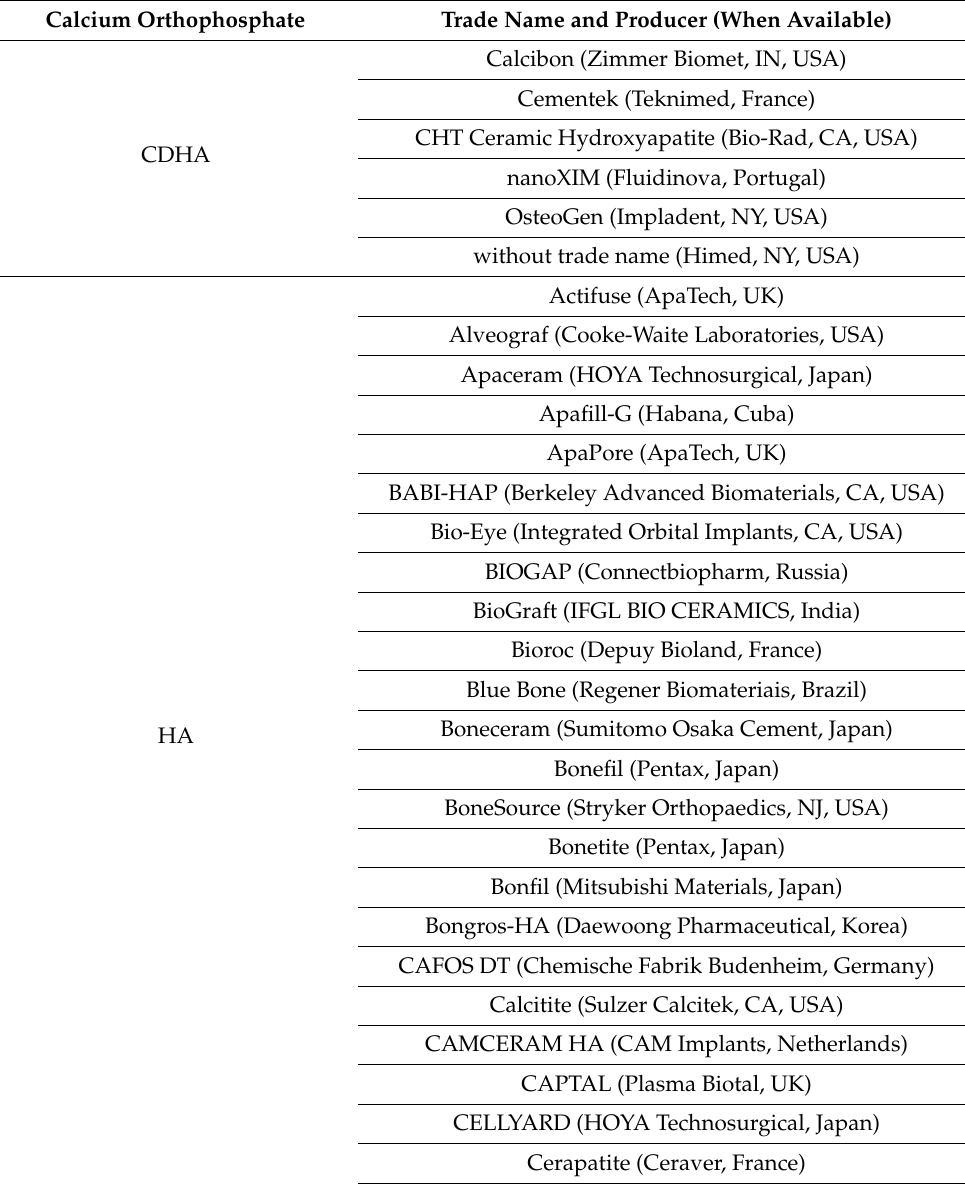
Table 3. Registered commercial trademarks (current and past) of CaPO 4 -based bioceramics and